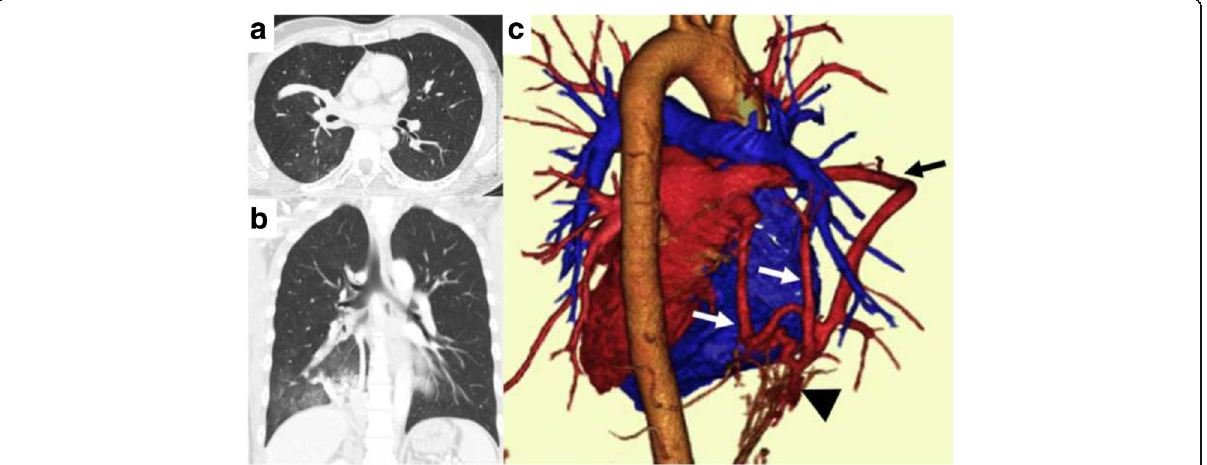
Fig. 1 Multiple anatomical abnormalities demonstrated by CT images and their 3D reconstruction. a Axial-plane CT reveals the presence of an arched vein contiguous with the superior and inferior pulmonary veins. b Coronal-plane CT shows a tracheal bronchus. c Three-dimensional reconstructed image demonstrates anomalous venous drainage ( arrows ) and a systemic arterial supply from the abdominal aorta through the diaphragm ( arrowhead ). Note that there are three main anomalous venous arches penetrating the right lung almost regardless of the lobes and connecting to one another at the bottom of the lung. Venous drainage from the upper lobe is preserved and relatively normal. Numerous abnormal arteries are coursing from the systemic circulation at the diaphragm; there might be a direct connection between these arteries and the anomalous venous system